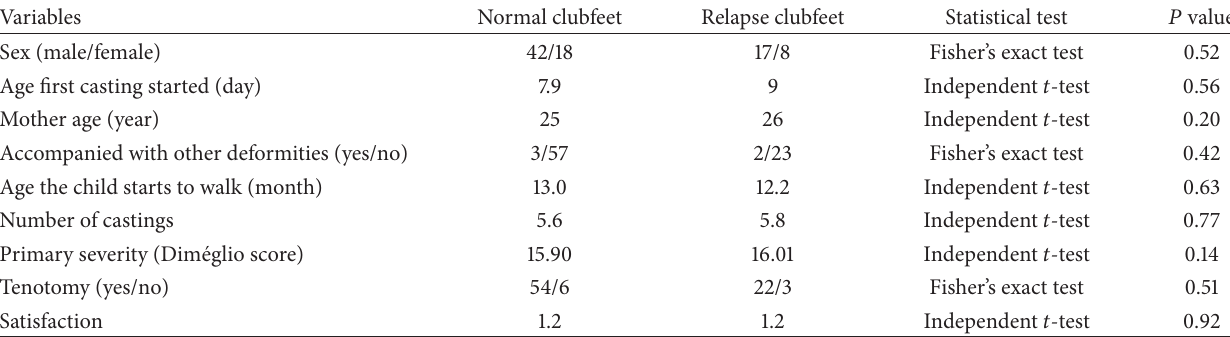
Table 1: Factors may relate to relapse in severe clubfeet managed with Ponseti method.